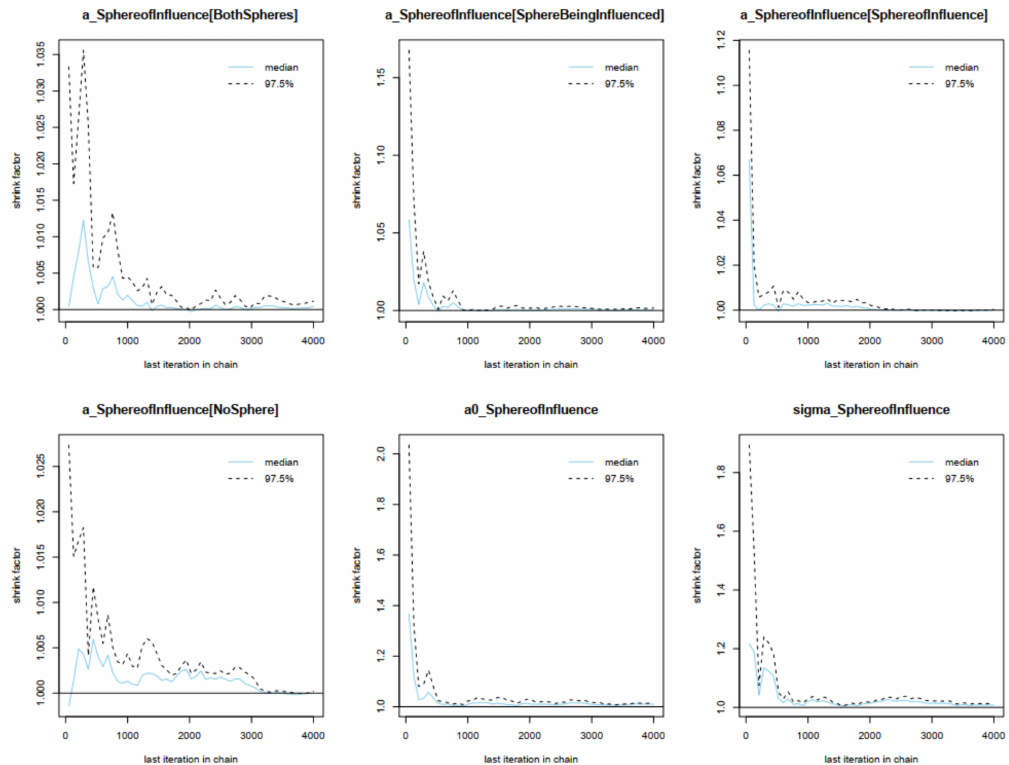
Figure A14. Model 5 (cid:48) s Gelman–Rubin–Brooks plots.